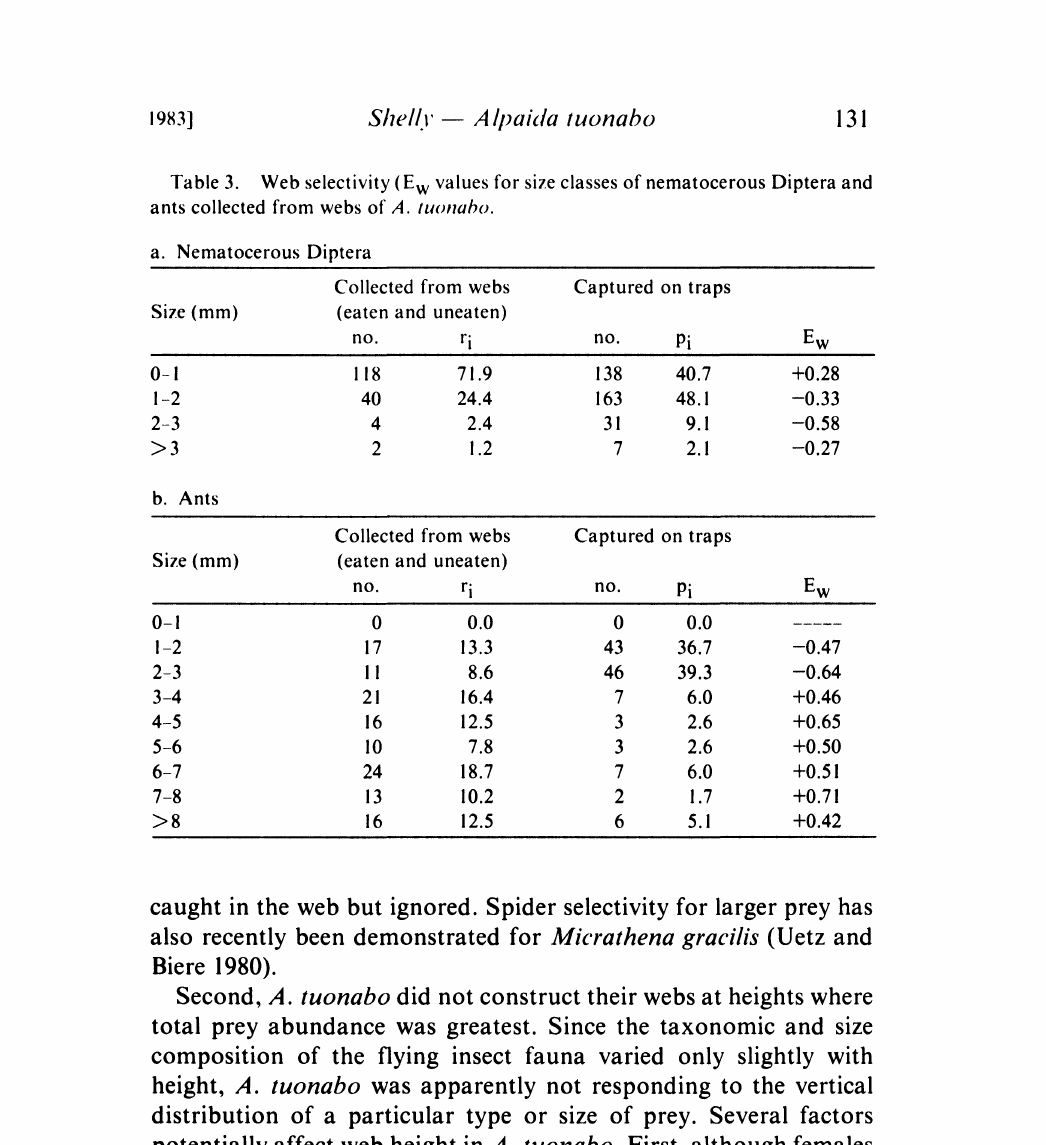
Table 3. Web selectivity (E w values for size classes of nematocerous Diptera and ants collected from webs of A.